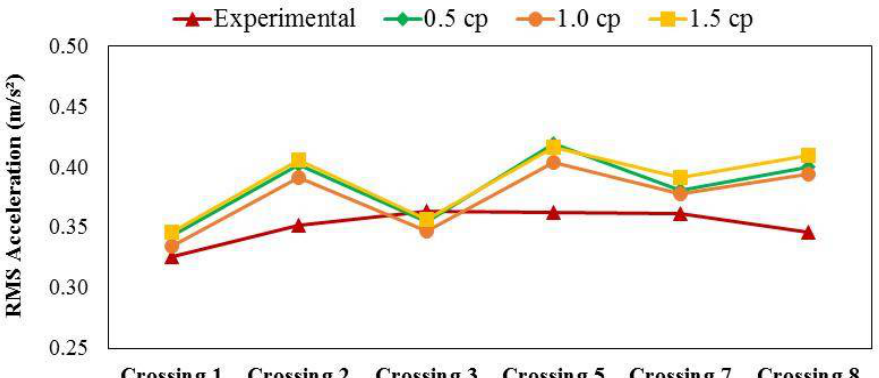
Figure 11. Results from changes in the modal damping.